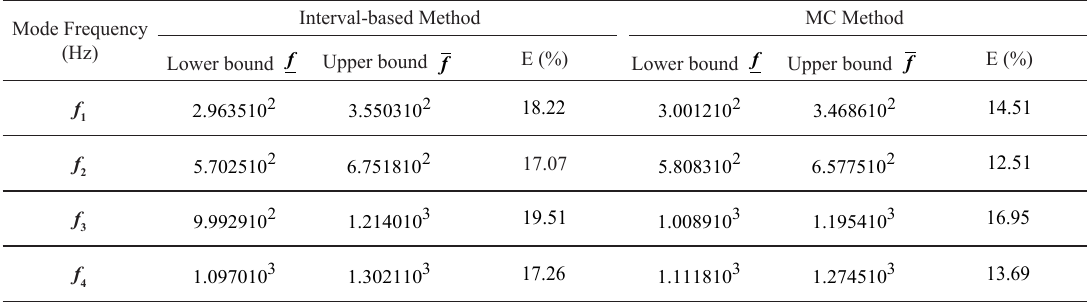
Figure 3. Output uncertain intervals and convex hulls for the interval-based procedure and MC Simulation for mode frequencies, where i f are the mode frequencies values in Hz. Table 1. Error-values for interval output variables obtained by the Interval-based Method and the MC